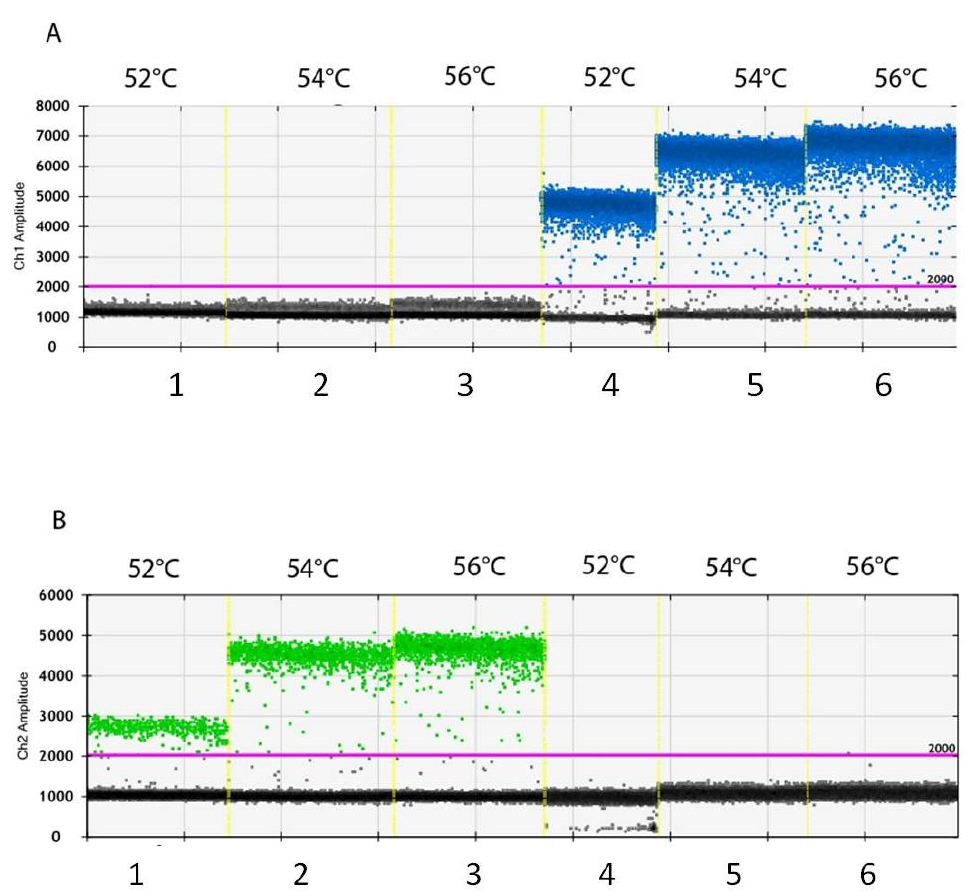
Figure 2. Amplitudes from channel 1 (FAM) ( A ) from channel 2 (HEX) ( B ) obtained during the second experiment to optimize the annealing/extension step and select the most performant DNA quantity. ddPCR assay was conducted for annealing/extension step, run at 52 °C (lanes 1, 4), 54 °C (lanes 2, 5), or 56 °C (lanes 3, 6) adding to the reaction 0.1 ng of gDNA purified from the monoco- nidial isolate B.1 (lanes 1–3) or from monoconidial isolate A.1 (lanes 4–6).